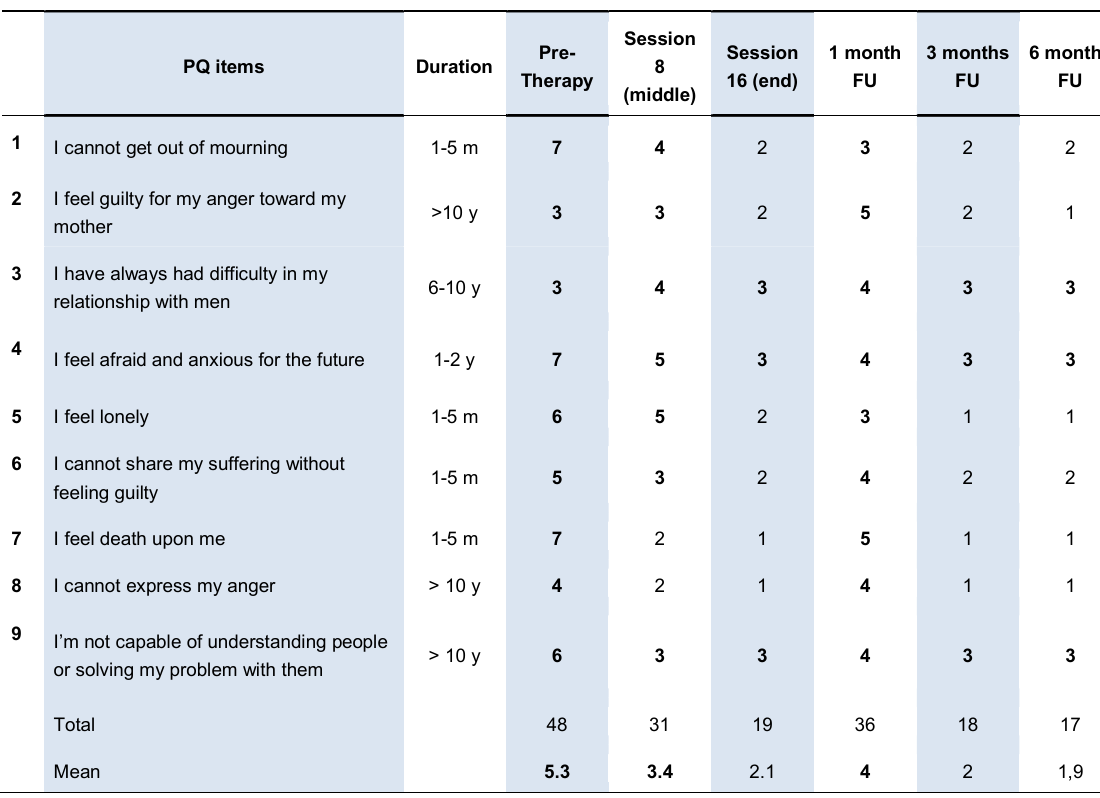
Table 3: Sara’s Personal Questionnaire items Note: Values in bold are within clinical range; The rating is on a scale from 1 to 7 and indicate how much each problem has bothered the client during the previous week: 1 = not at all; 9 = completely. FU = Follow Up. m = month. y =